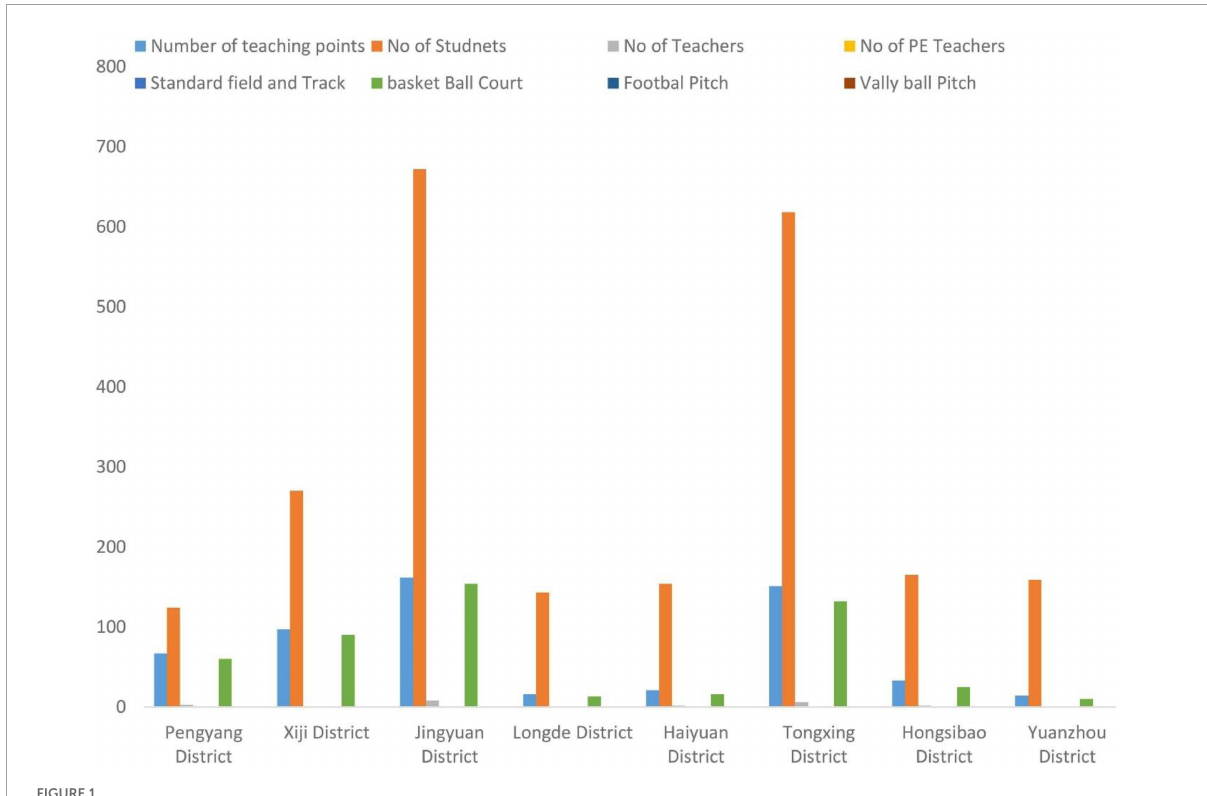
FIGURE1 Status of non-availability of PE facilities (Source: author’s pilot